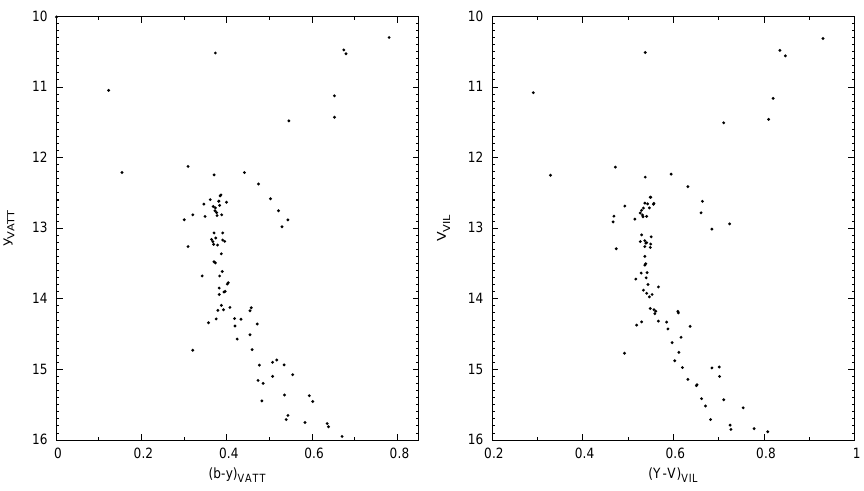
Fig. 1. Comparison of color-magnitude diagrams from VATT and Laugalys et al. (2003) in the Vilnius system. Only common stars are